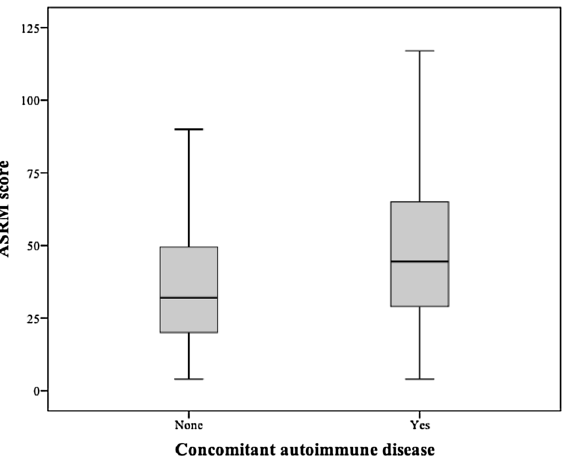
Figure 1. Boxplots of ASRM score according with autoimmunity status. We compared mean ASRM score between women without autoimmunity and women with concomitant autoimmune disease. ASRM score, American Society for Reproductive Medicine.